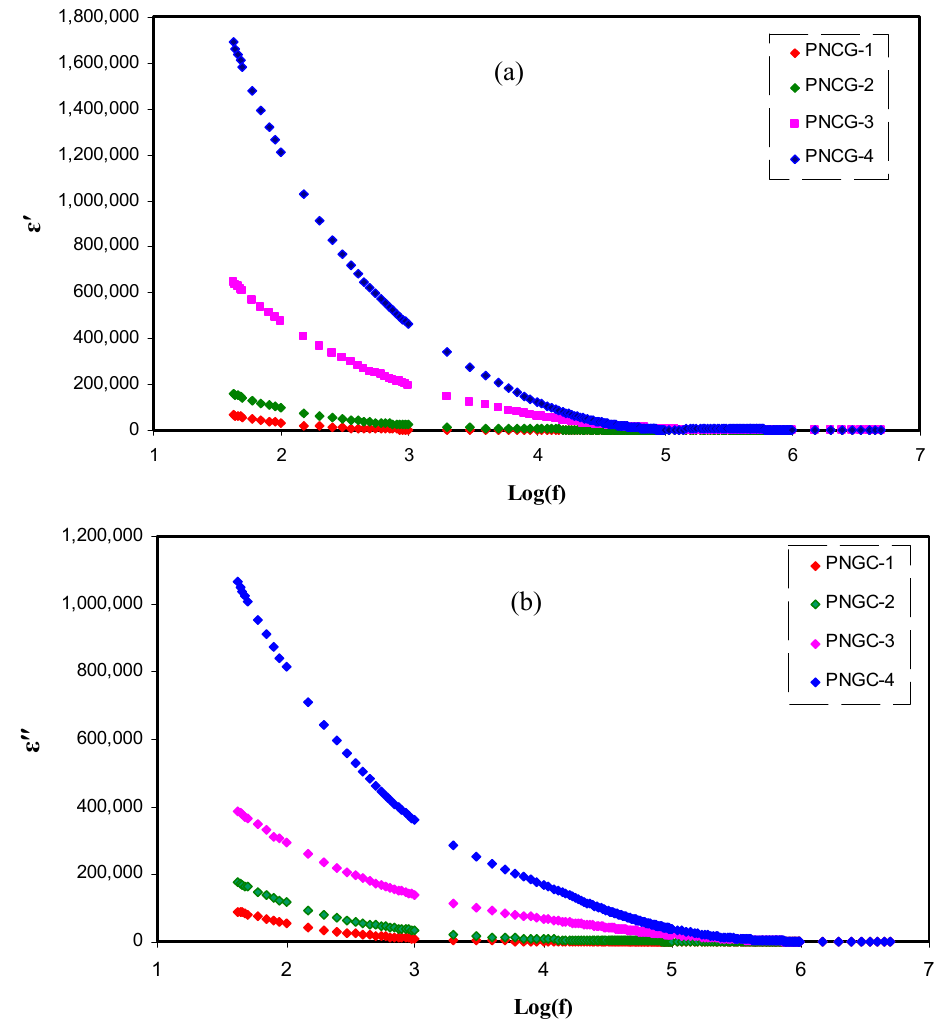
Figure 5. Complex dielectric constant plot ( a ) ε ’ versus log (f) and ( b ) ε ” versus log (f) for all polymer composite electrolytes(PCEs).